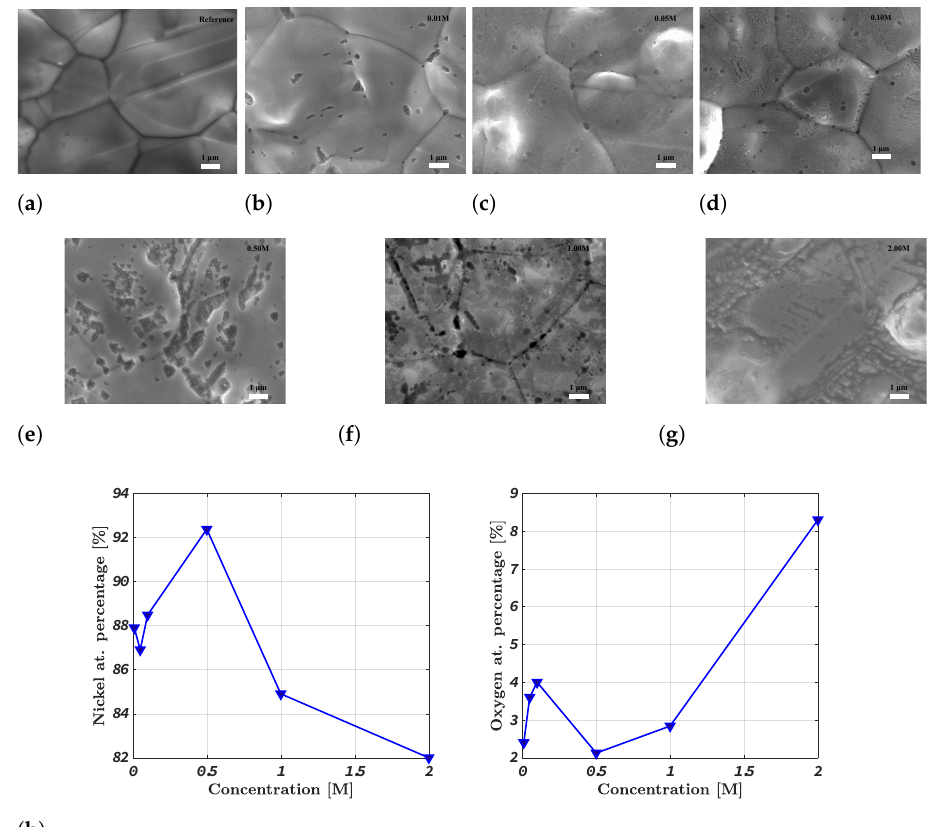
Figure 2. ( a – g ) SEM figures of the pristine H 2 SO 4 -treated nickel foam electrodes showing the gradual increase in surface roughness. ( h ) The EDS-determined atomic surface concentrations of nickel and